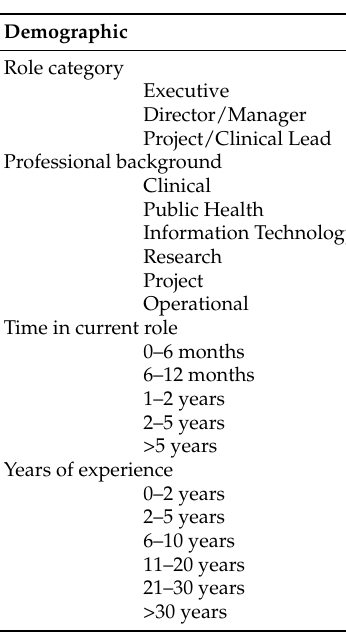
Table 2. Participant characteristics in the present study ( n =